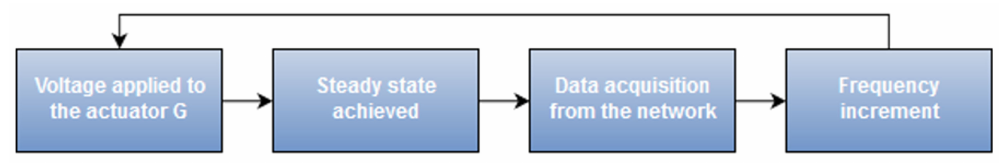
Figure 10. Data acquisition